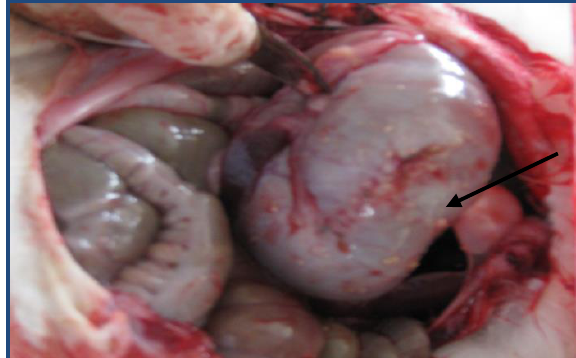
Figure, 2: Gross photograph of a rabbit in G2, at the 7th P.O. day. Showing no adhesions at the operation site and also between all abdominal organs, with presence of some chitosan remnant granules (a row), in abdominal (cavity score (0) adhesion).